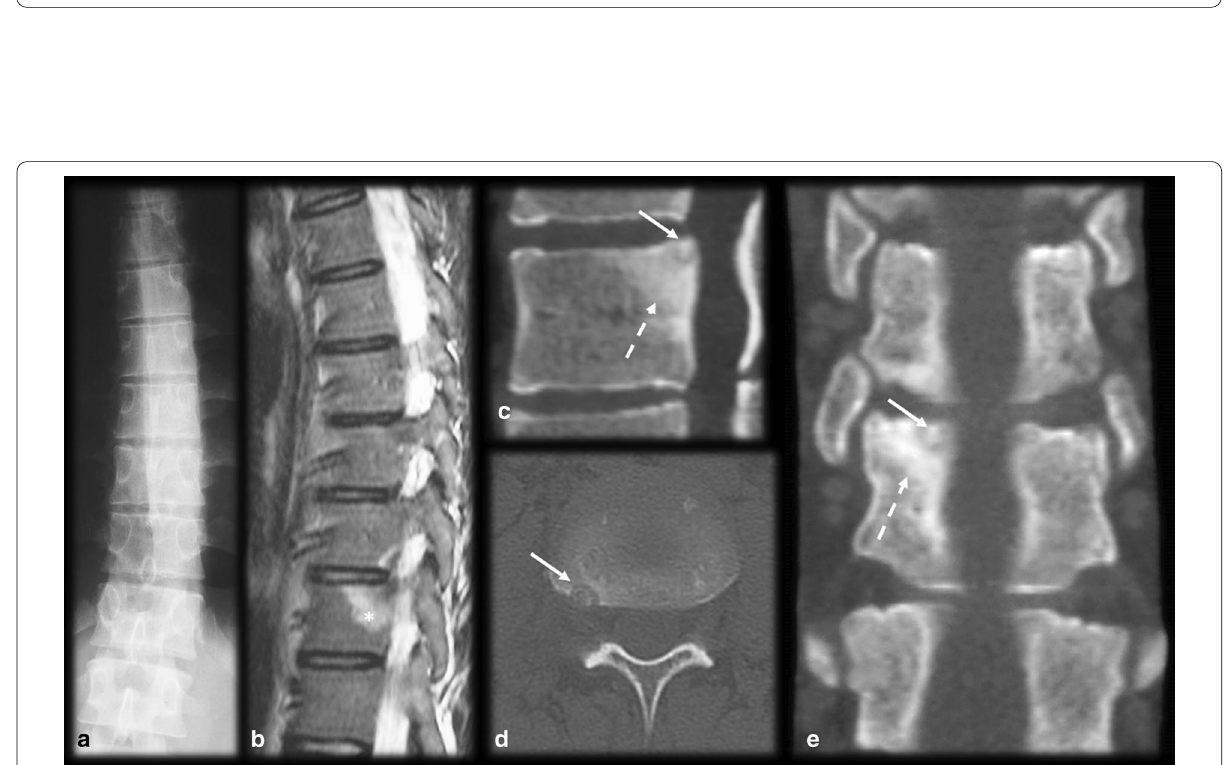
Fig. 17 Osteoid osteoma mimicking anterior impingement. A 29-year-old male presenting with anterior ankle pain for 4 months. CR ( a ) showed mild sclerosis on the dorsal talar neck (arrow). T1 ( b ), T2 ( c , d , e ) and CT ( f ) showed a mineralized nidus (dotted arrows) with reactional synovitis (arrowhead), bone marrow edema (asterisk) and sclerosis